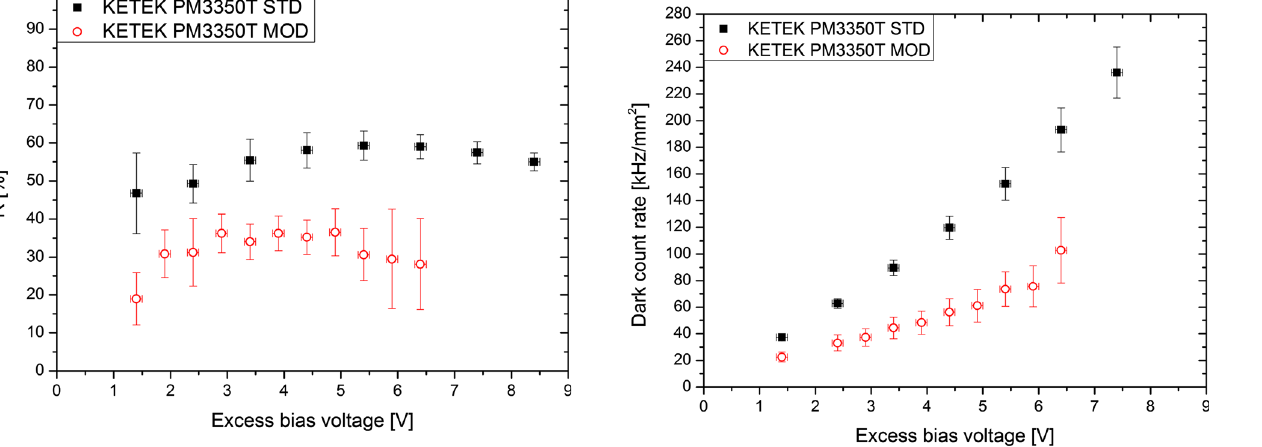
Fig. 17 Dark count rate as a function of Δ V at ( 21 ± 1 ) ◦